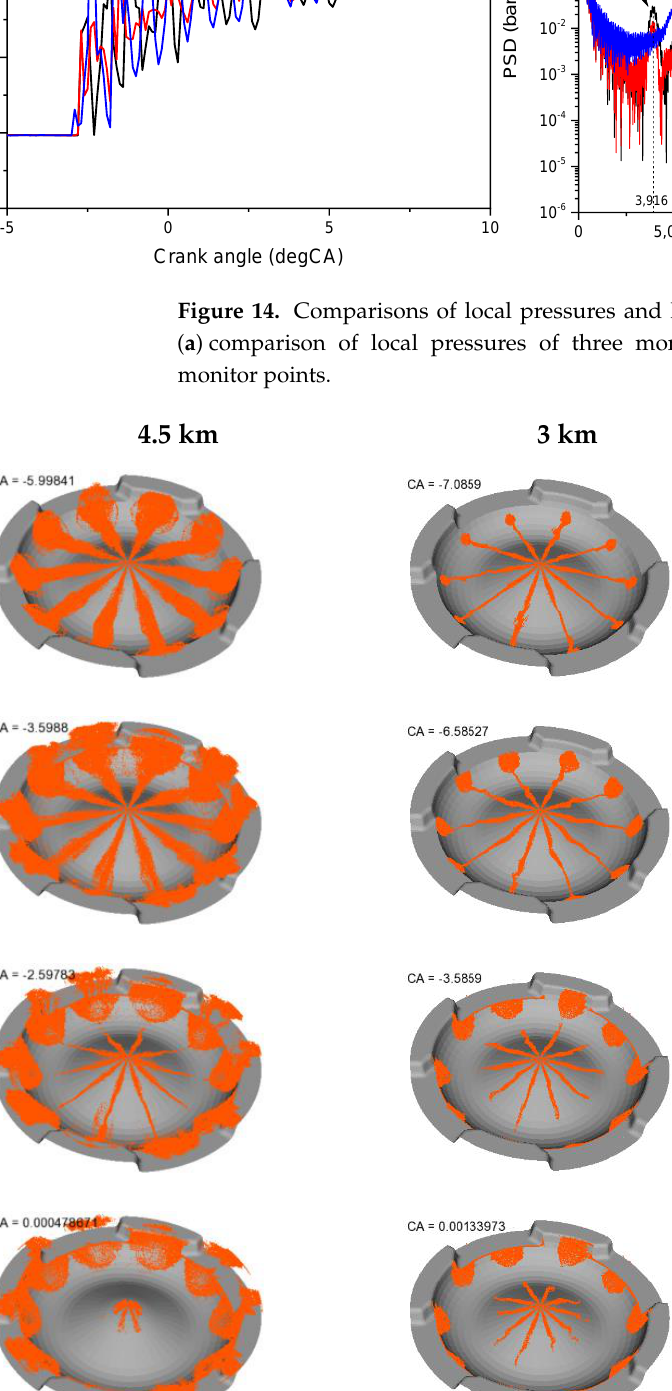
Figure 16. Comparison of spray tip penetration measured in a constant volume vessel at various altitudes (injection pulse = 2 ms, injection pressure = 40 MPa, and ambient temperature = 700 K).